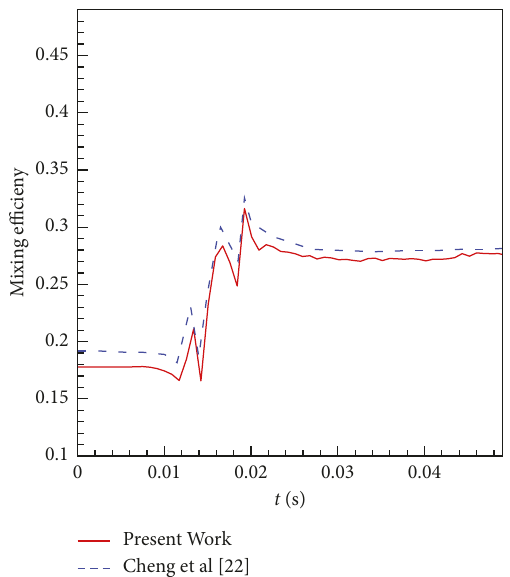
Figure 5: Comparison between mixing efficiency of present work and Cheng et al. [22] at f � 400Hz with sine